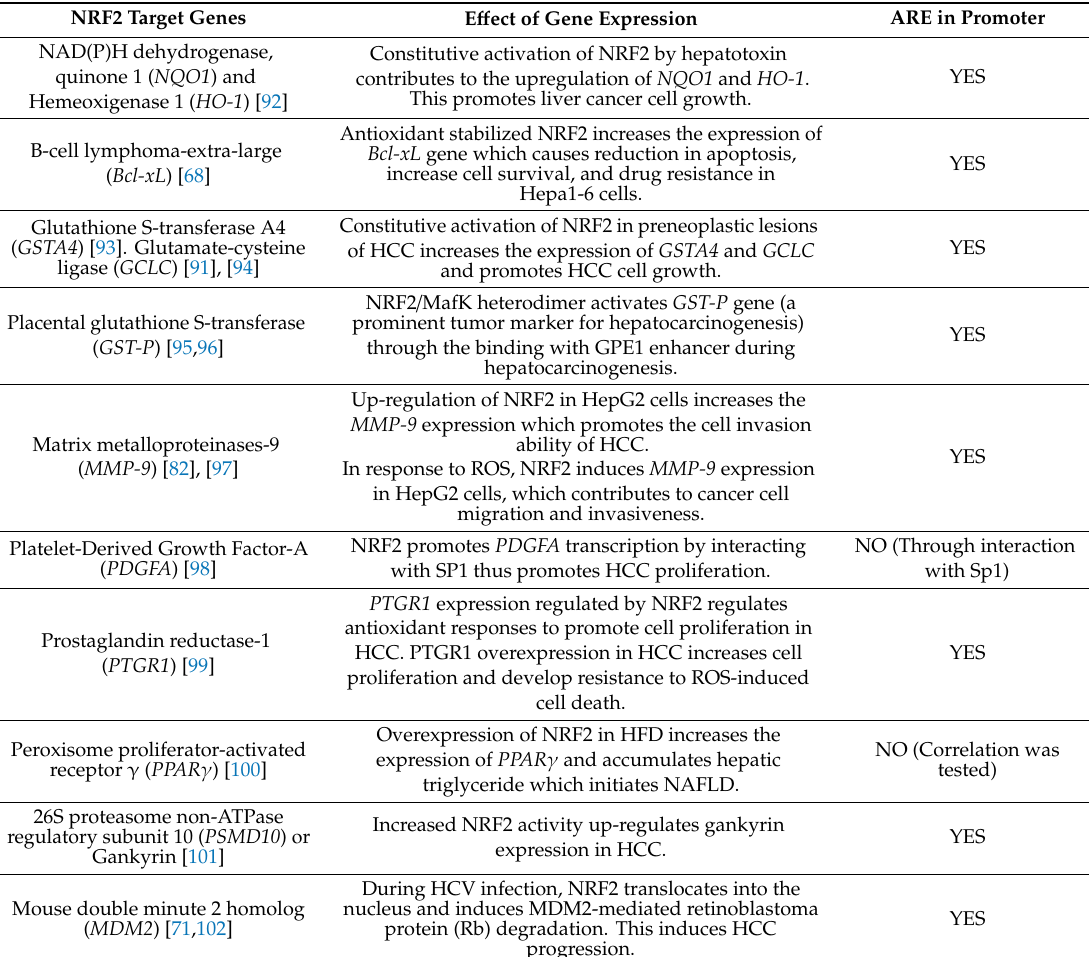
Table 2. List of NRF2 target genes and their e ff ects on HCC